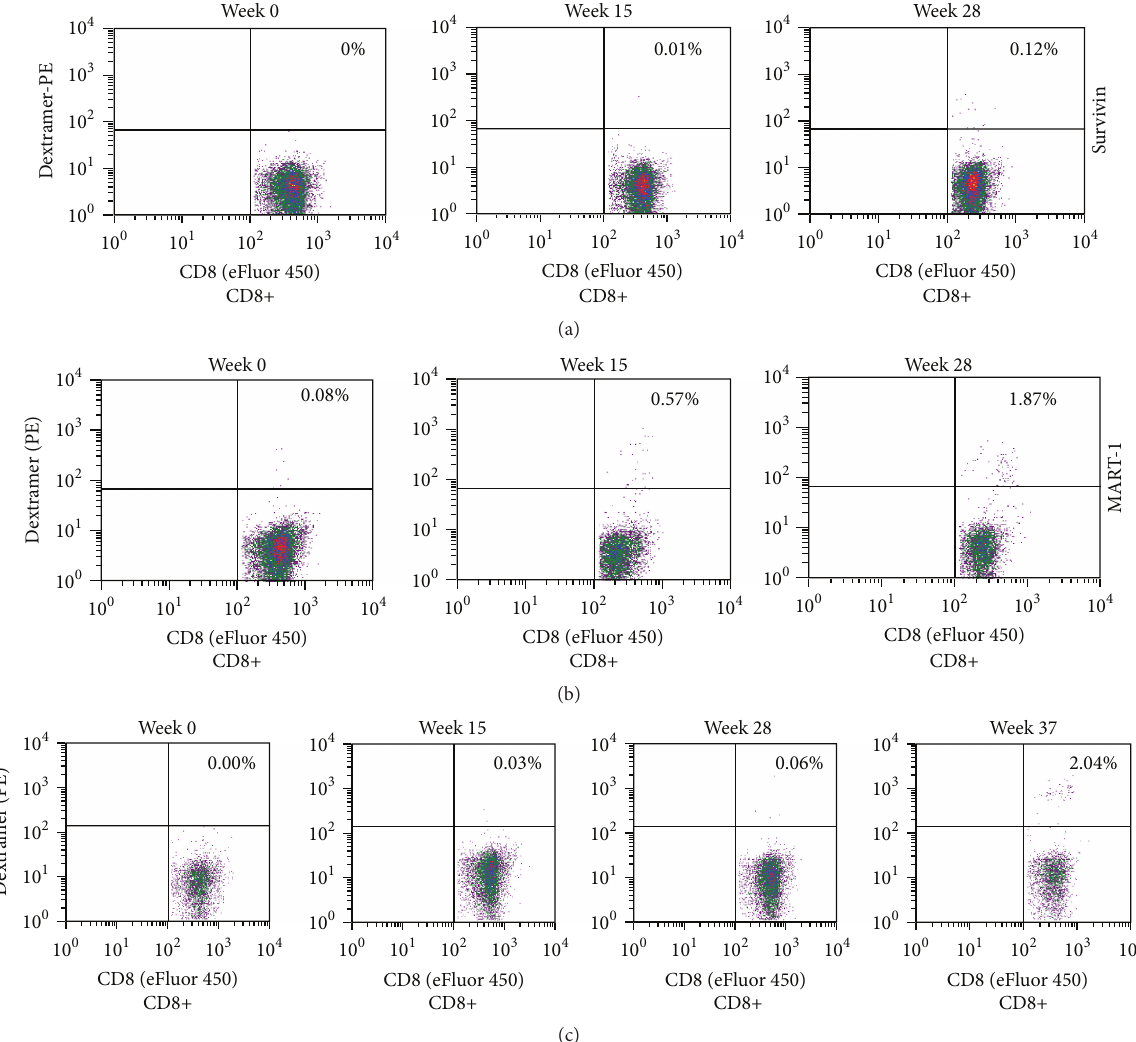
Figure 3: Analysis of CD8+ T-cell response following vaccination. PBMCs prior to (week 0) and following (weeks 15, 28 and 37) vaccination were cultured with either (a) HLA-A ∗ 0201-restricted survivin, (b) MART-1, or (c) NY-ESO-1 peptide (10 𝜇 g/mL). The cells were cultured in a 96-well plate, harvested at day 10, and then stained with phycoerythrin- (PE-) conjugated survivin (LTLGEFLKL), MART-1 (EAAGIGILTV), or NY-ESO-1 (SLLMWITQV) dextramer (Immudex) for 10 min followed by anti-CD8, anti-CD19, and anti-CD56 staining (20min). Subsequent to being washed, gated CD8+ T-cell population was analysed for dextramer-staining on a BD SLR II flow